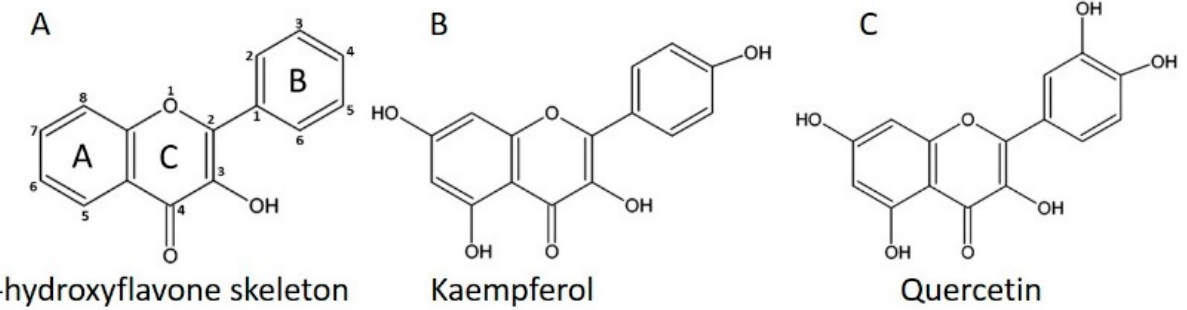
Figure 1. Chemical structure of 3-hydroxyflavone, kaempferol and quercetin. ( A ) shows flavonol skeleton, ( B ) shows kaempferol and ( C ) shows quercetin structure.